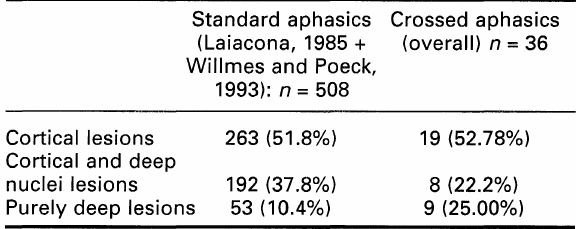
TABLE III. Prevalence of standard and crossed aphasics according to the lesion site in different samples. Standard aphasics Crossed aphasics (Laiacona, 1985 + (overall) n = 36 Willmes and